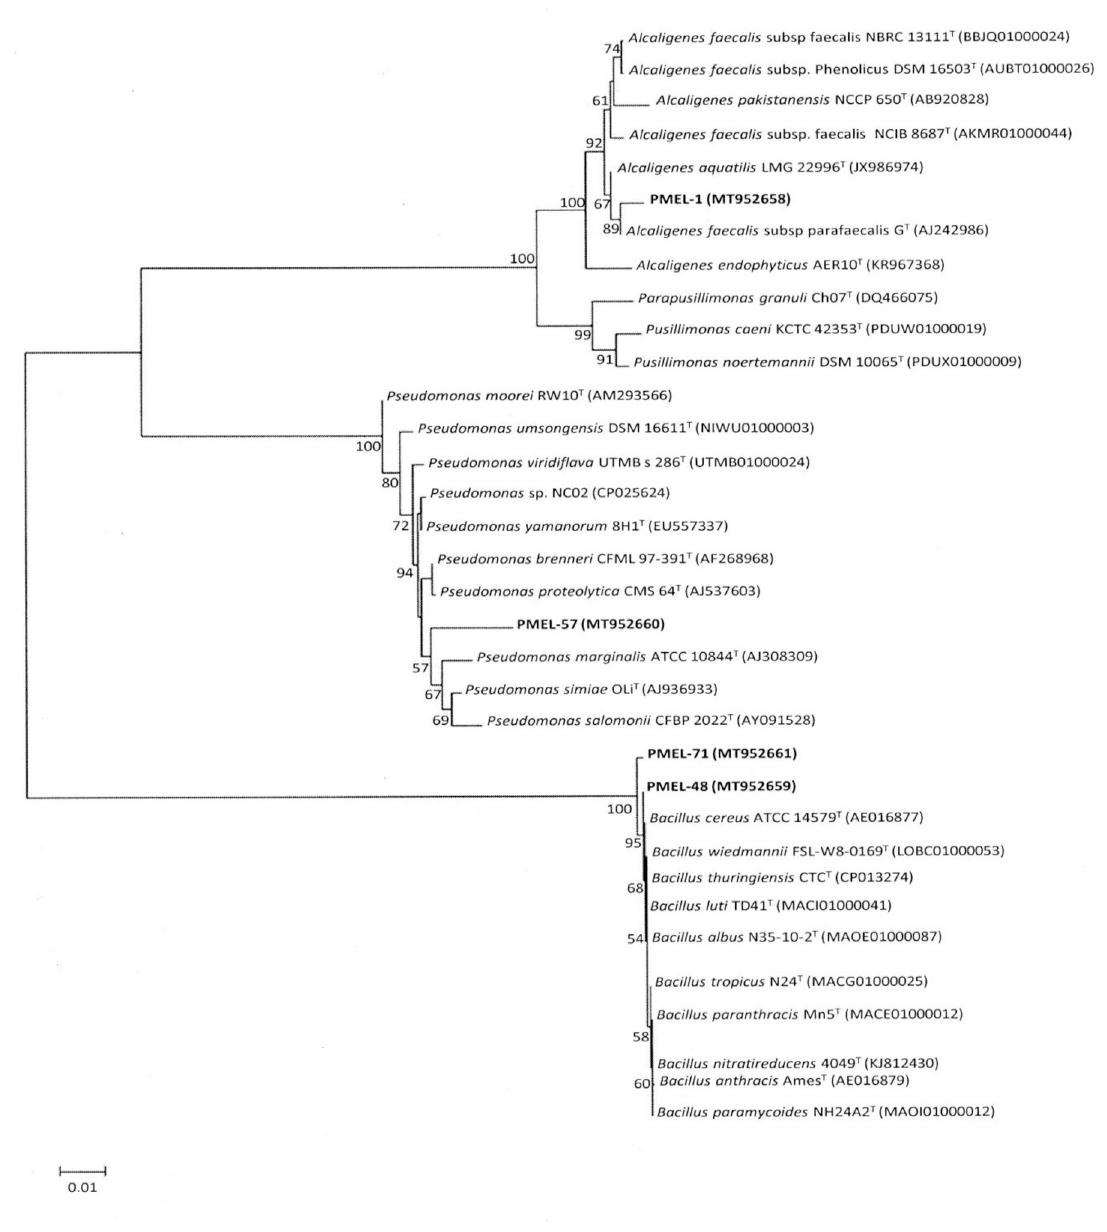
Fig 1. Phylogenetic tree constructed from comparative analysis of 16S rRNA gene sequences showing the relationships between strains PMEL-1, PMEL-48, PMEL-57 and PMEL-71 and their related species of different genera (Table 5). The tree was constructed by using the neighbour-joining method and Jukes & Cantor evolutionary distance matrix data obtained from aligned nucleotides. Bootstrap values (expressed as percentage of 1000 replications) greater than 50% are shown at the branch points. Bar, 1 substitution per 100 nucleotide